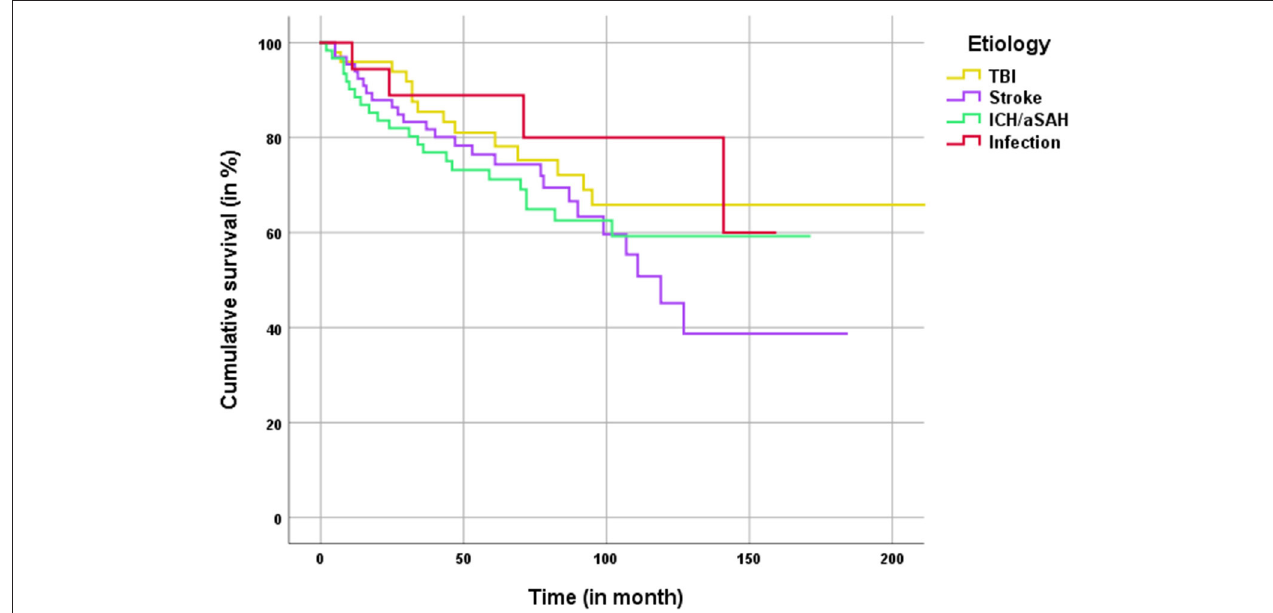
FIGURE 3 | Kaplan–Meier analysis for patient survival classified by the main etiology for craniectomy.